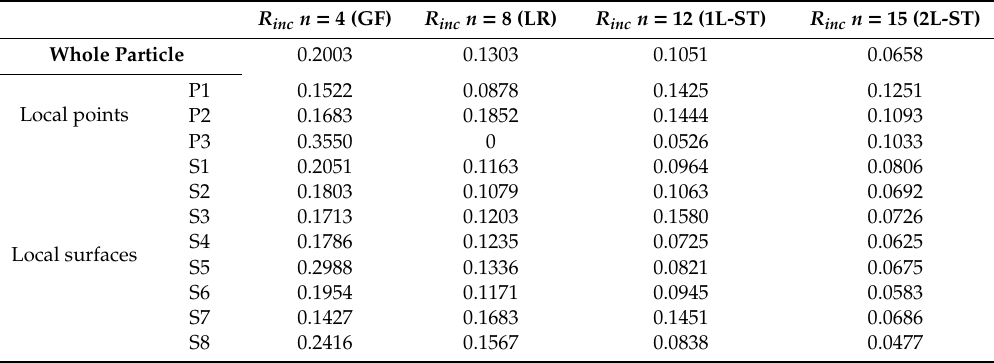
Figure 10. Visualization of local points and surfaces. Table 4. Surface roughness anisotropy by R inc for a given particle.